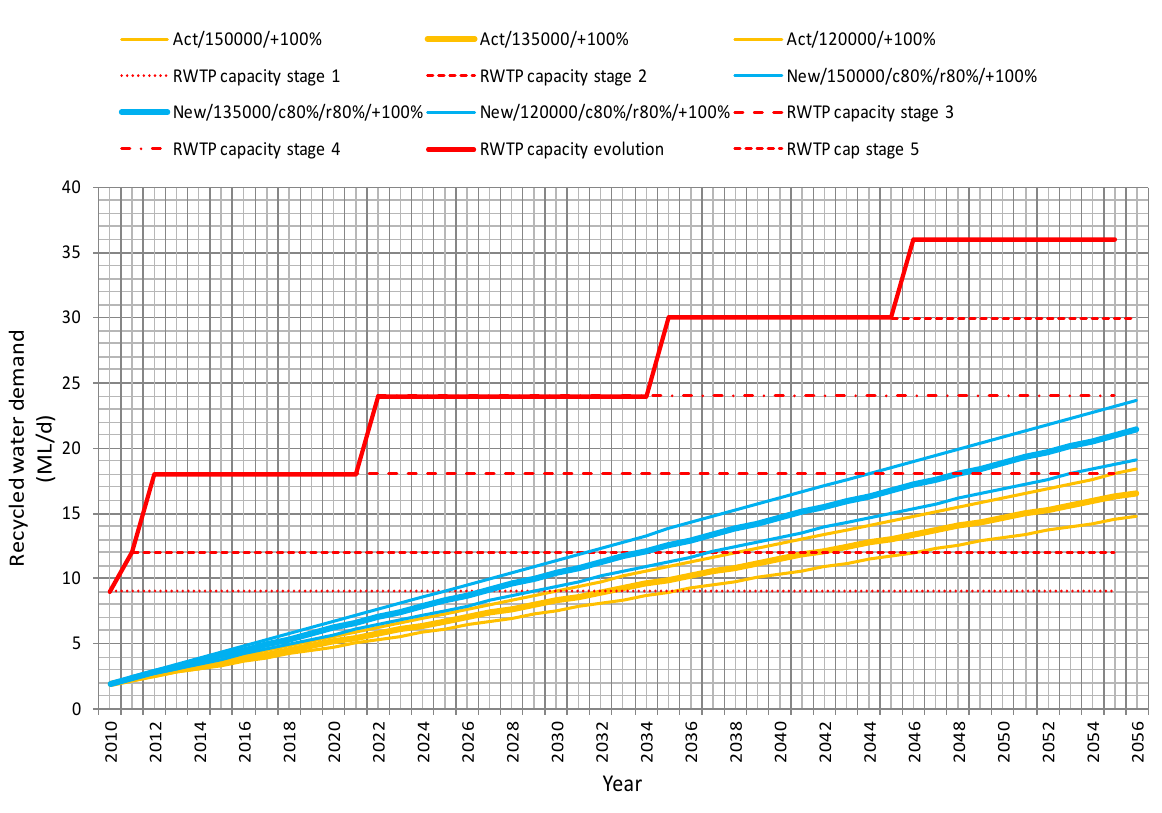
Figure 3. Recycled water demand prediction for base case scenarios (peak factor =